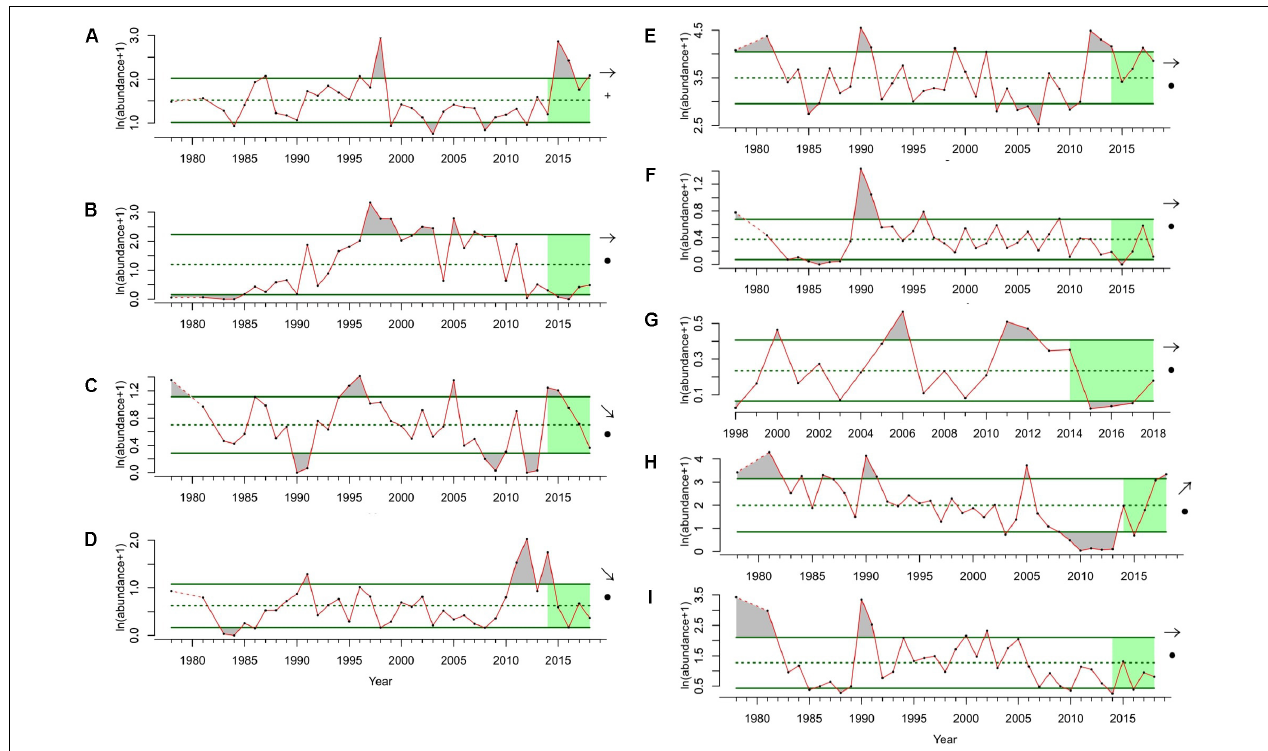
FIGURE 4 | Indicator taxa from the CalCOFI time-series that are used for the California Current Integrated Ecosystem Assessment (CCIEA). On left (A–D) are groups or species that exhibit a warm-affinity and may increase in total and relative abundance in the future: (A) warm-water mesopelagic fish larvae, (B) Pacific Sardine, (C) Jack Mackerel, and (D) Sanddabs. On right (E–I) are groups or species that exhibit a cold-affinity and may decrease in total and relative abundance in the future: (E) cold-water mesopelagic fish larvae, (F) Shortbelly Rockfish, (G) Market Squid, (H) Northern Anchovy, and (I) Pacific Hake. Time series come from spring CalCOFI surveys (1978–2018) on lines 76.7–93.3 and stations 28.0–120.2. Larval fish data are summed across all stations and units are in number of larval fish under 10 m 2 of surface area, transformed using ln(abundance + 1). Dotted line shows long term mean, solid green lines show standard deviation, and recent 5 years trend for each taxa is indicated by the arrow on the right of each time-series. Green shading indicates the last 5 years of the